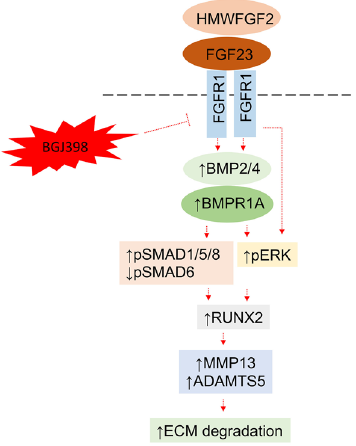
Figure 10. Diagrammatic proposed mechanism of signaling pathways in articular cartilage modulated by BGJ398 blocking HMWFGF2-generated OA development. HMWFGF2 increases FGF23 expression that binds to FGFR1. Activation of FGFR1 upregulates degrading enzymes MMP13 and ADAMTS5 expression via SMAD 1/5/8 and ERK regulated RUNX2 expression. FGFR inhibitor BGJ398 inhibits activation of FGFR1 and, therefore, rescues/prevents OA development in HMWTgFGF2